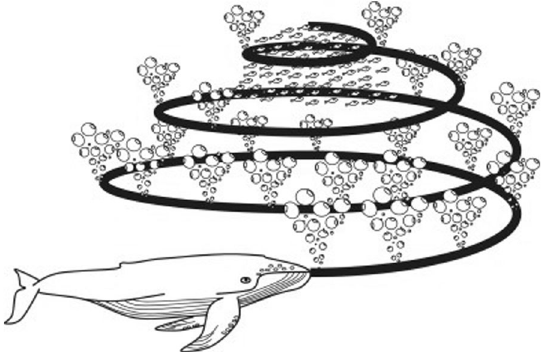
Fig. 1 Bubble - net feeding method of humpback whale